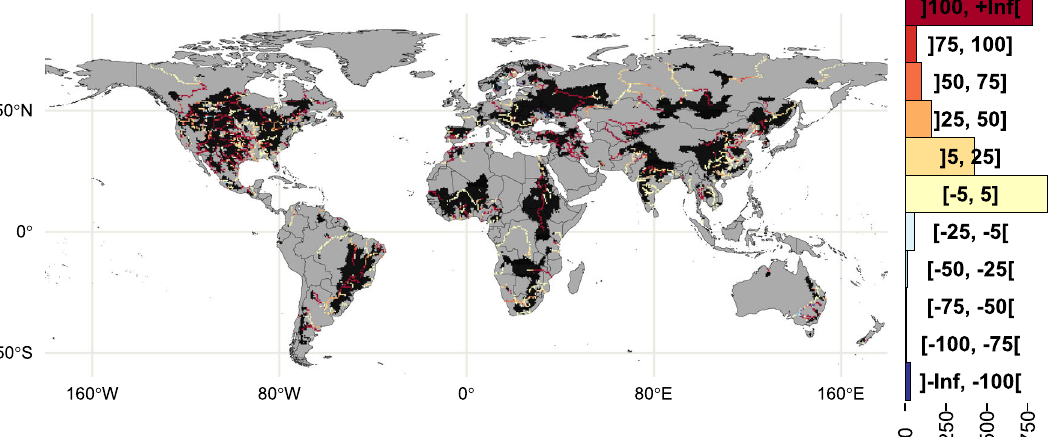
Fig. 2 Projected difference in multi-model median return period (years) in 21 C for discharge corresponding to the historical 100-year fl ood between the experiment not considering dams minus the experiment considering dams. Grid-cells belonging to Köppen – Geiger regions BWk , BWh (hot and cold desert climates, respectively), and EF (ice cap climate) and for which the 30-year return period discharge was lower than 5 m s − 1 were systematically screened out (see Methods). The case for representative concentration pathway (RCP) 6.0 is shown (RCP2.6 available in Supplementary Fig.